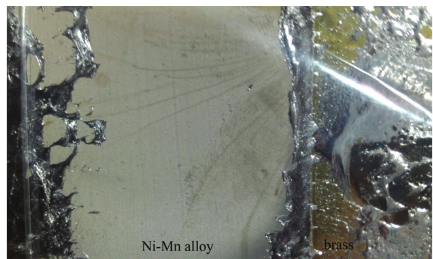
Figure 5: The photograph of specimen after being dipped in molten tin for testing its nonsticking